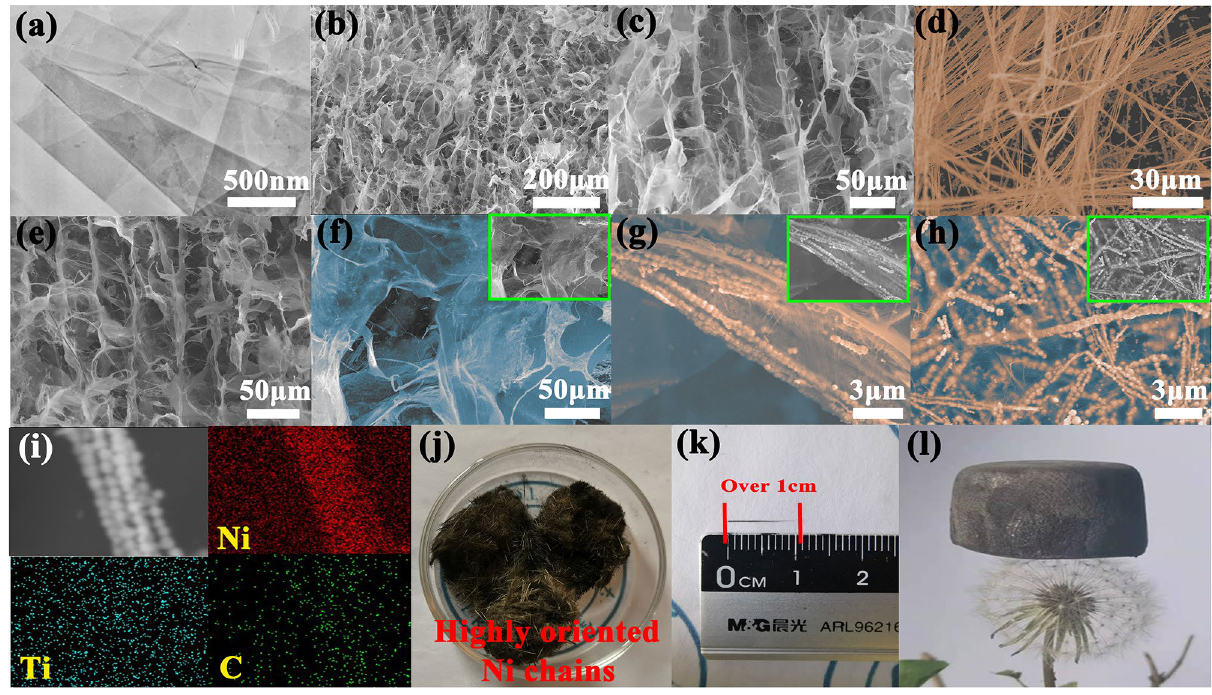
Fig. 2 TEM and SEM images of a few-layered Ti 3 CNT x , b BCA, c BCMA, d highly oriented Ni chains, and e – h BCMNA-1, and blue, orange and white colors represent